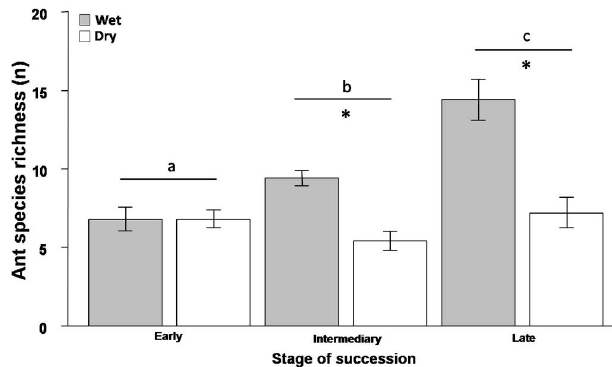
Fig 1 . Species richness of arboreal ants in response to season (dry and wet) and among three forest fragments of Caatinga, with diffe- rent stages of succession. Different letters above bars indicate signi- ficant differences amongst successional stages, while asterisks indi- cate differences between seasons within a same stage.